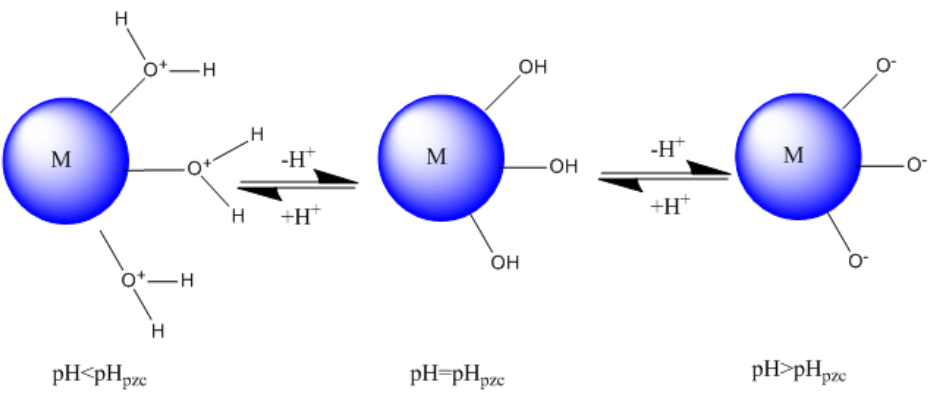
Figure 11. Change in surface contamination of the composite material (M represents HAp/HPMC composite) as a function of pH.